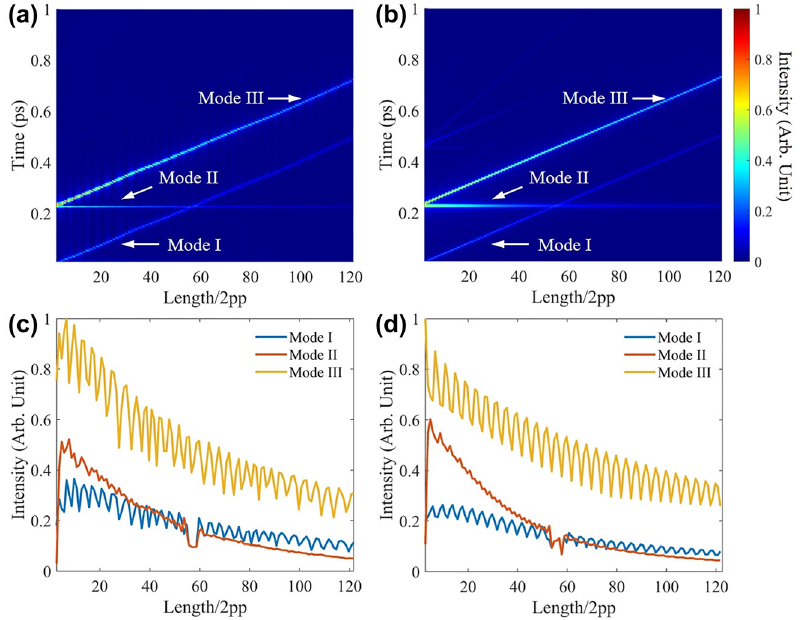
Figure 3: Mode evolution in the reciprocal space (a) experiments and (b) theory. The intensities of the three modes in (c) experimentsand(d) theory.pp standsfor the positive pulse, and 2pp equals 1.25 μ